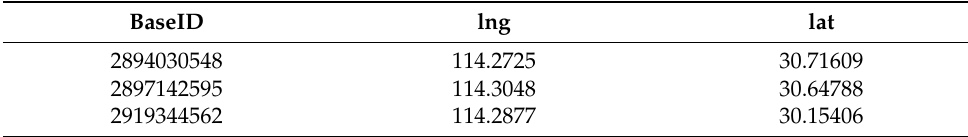
Table 4. Example of communication base station